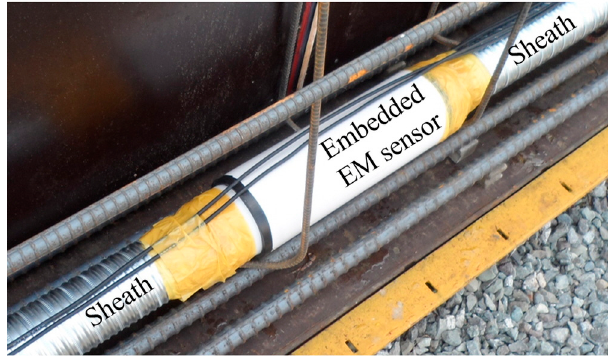
Figure 3. Installation of an embedded EM sensor.